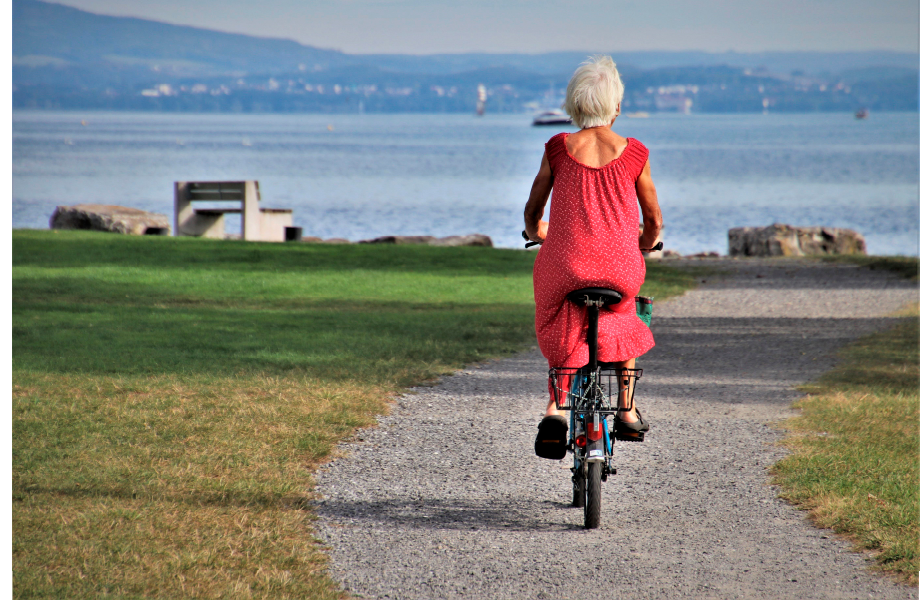
Figure 2. Older woman cycling. Source, Canva. https://pixabay.com/es/photos/parque-la-bicicleta- mayor-solitario-5528190/ (accessed on 20 November